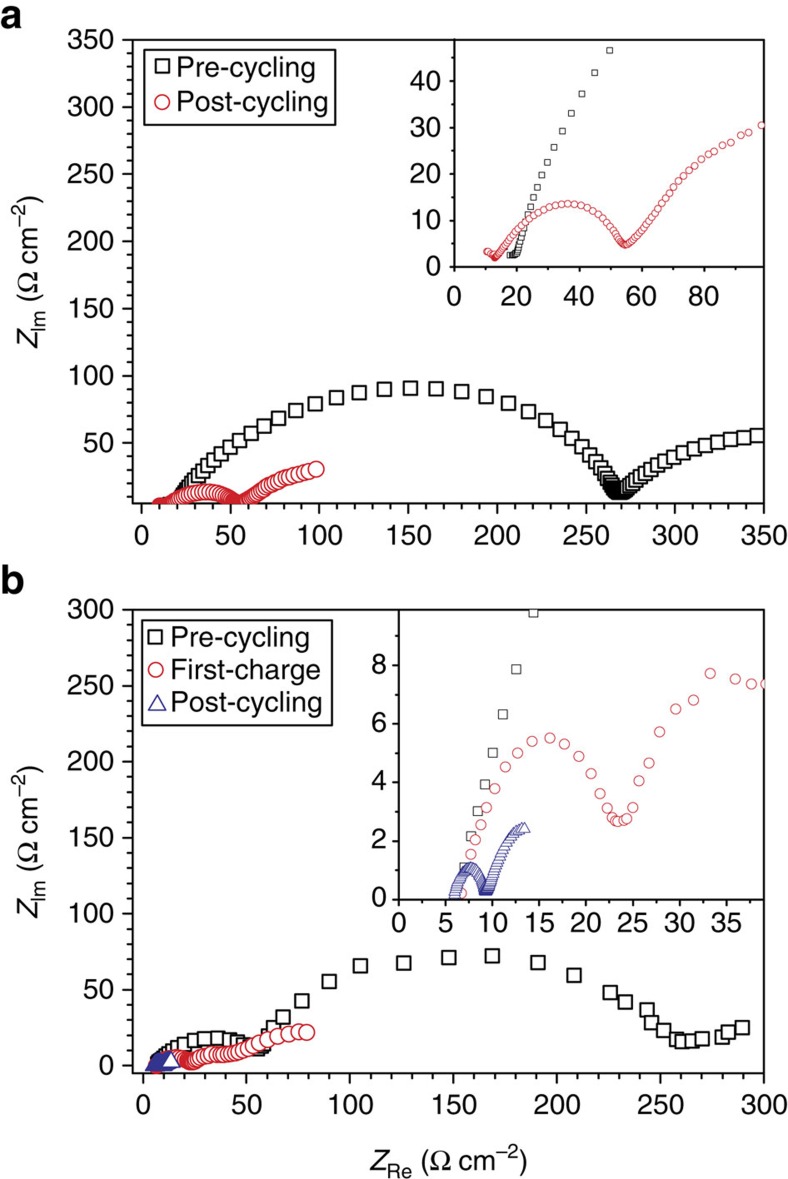
Electrochemical impedance spectroscopy of pristine and 12-day pretreated Li-symmetrical cells.Nyquist plots for a Li-symmetrical cell containing (a) LiAsF6/[C3mPyr+][FSI−] electrolyte before (black) and after 5,000 cycles (red) at 0.1 mA cm−2 and (b) 12-day pretreated Li electrode in LiFSI/[C3mPyr+][FSI−] electrolyte before (black) after one charge (red) and after 333 cycles (blue) at 1.0 mA cm−2.